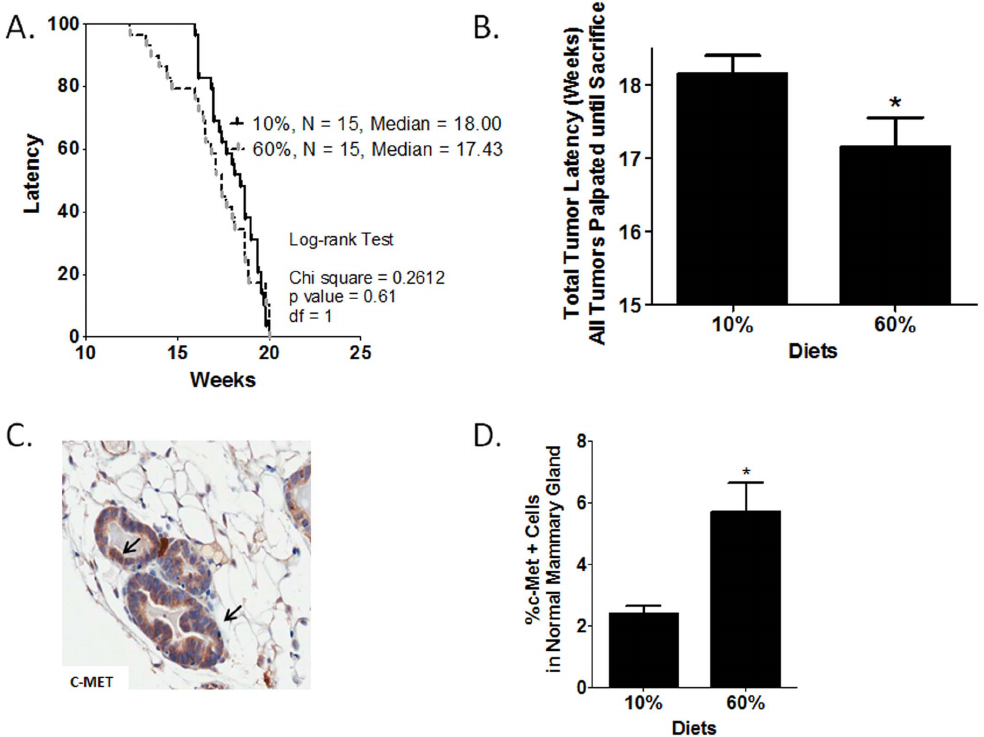
Figure 1. Obesity and parity regulated a decrease in BBC latency and elevated c-Met in normal mammary glands. A) Upon initiation of diet at 10 weeks of age, parous mice were palpated three times a week for tumor onset (first tumor detected) (N=15). Using the Kaplan-Meier analysis the hazard ratio comparing 60% to 10% was 1.151 (95% CI of ratio: 0.67 to 1.98). Median latencies in 10% and 60%-fed mice were 18.00 and 17.43 weeks, respectively. Using a chi-square test with a degree of freedom of 1, 10% vs. 60% equaled 0.61. B) Mean latencies of total tumors palpated from initial until sacrifice are shown. N=30 tumors in 15 mice per group. *P=0.002. C) Representative 40X photomicrographs of the IHC analysis of membrane localized c-Met staining (arrows). D) Total c-Met protein levels in normal mammary glands were quantified. *P=0.003.